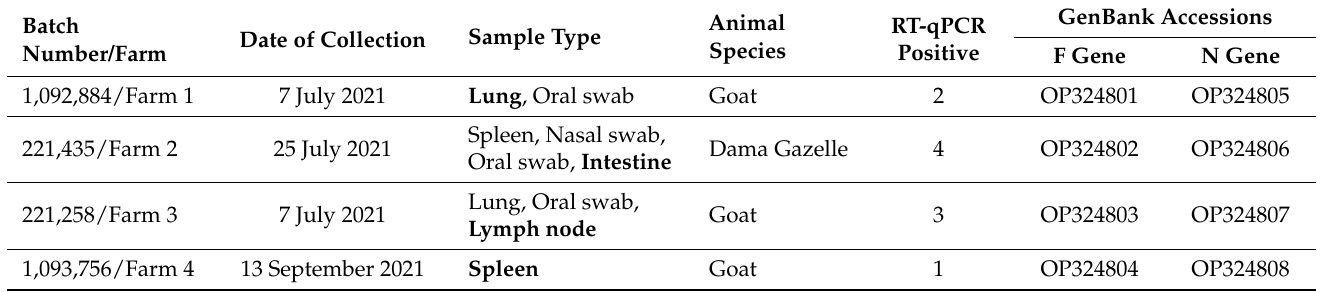
Table 1. Information of the samples used in the